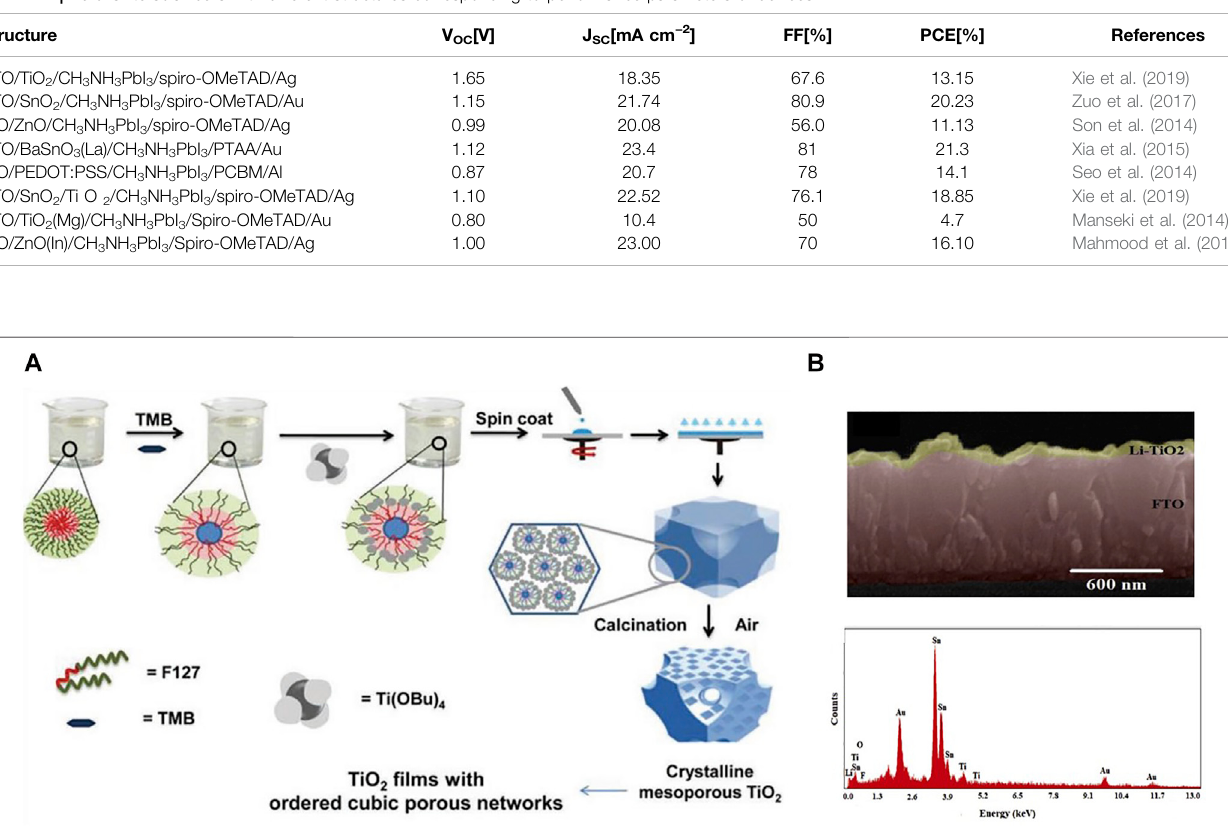
Frontiers in Bioengineering and Biotechnology |